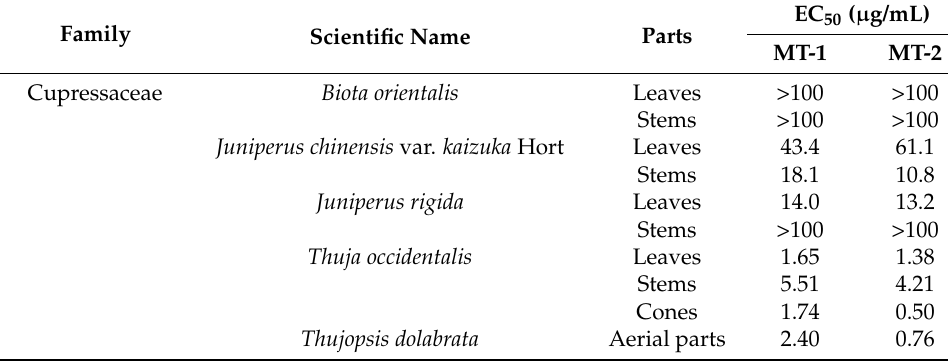
Table 1. Anti-proliferative activities of the tested plant extracts.